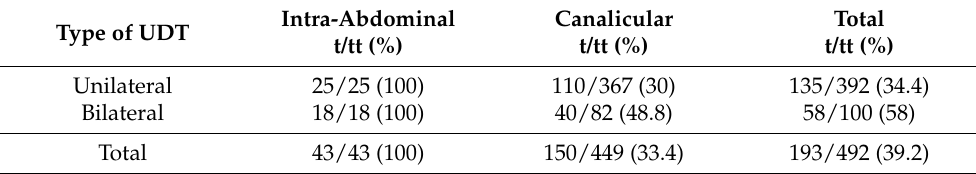
Table 4. Gonads with TEVA regarding unilateral or bilateral UDT.